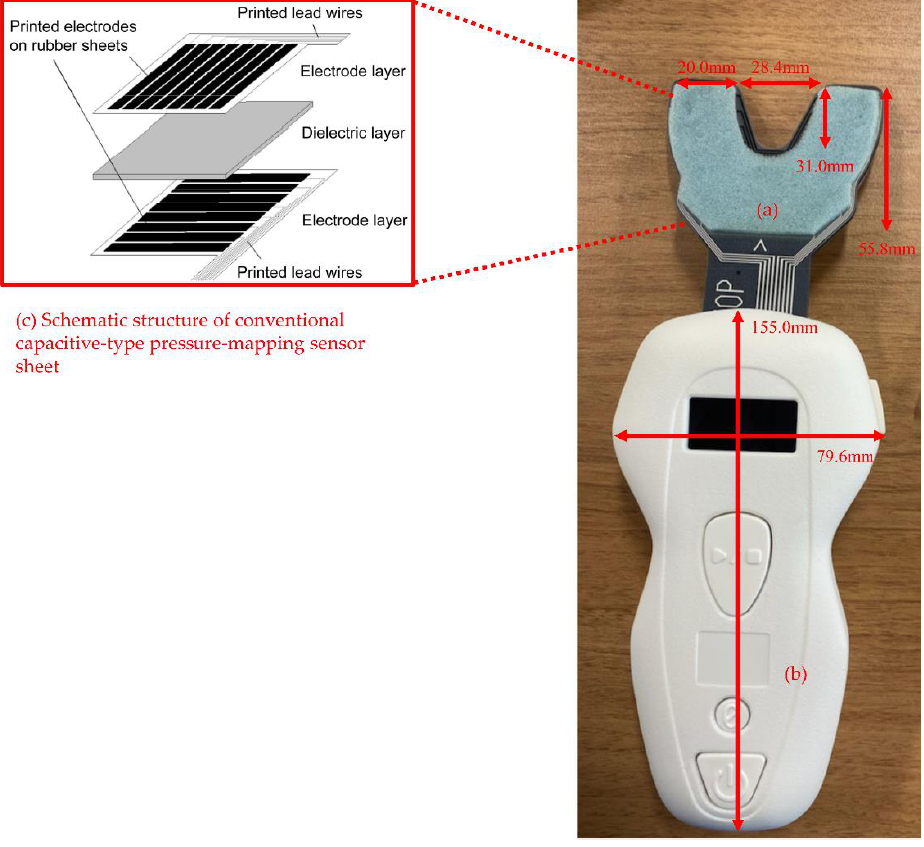
Figure 1. Appearance of occlusal force-measuring device with a capacitive-type pressure-mapping sensor (OFMD-CPS). Figure 1 legend: The OFMD-CPS consists of ( a ) a sensor sheet (pressure-sensitive area) and ( b ) a main body with built-in circuit board for the capacitance value measurement. The sensor sheet ( a ) has a three-layer structure, composed of a dielectric layer (urethane sponges) sandwiched between two polymer film sheets (polyethylene terephthalate) as shown in ( c ), and was designed according to the shape of the dental arch. Electrodes were patterned on a polymer film sheet using a screen-printing technique involving special ink. Electrodes were arranged such that the electrodes on the two sides intersected at right angles. One capacitive-type sensor was formed by the intersection of two electrodes. The thickness of the sensor sheet was 1.6 mm, which was reduced to 0.3 mm or less when a bite load was applied.